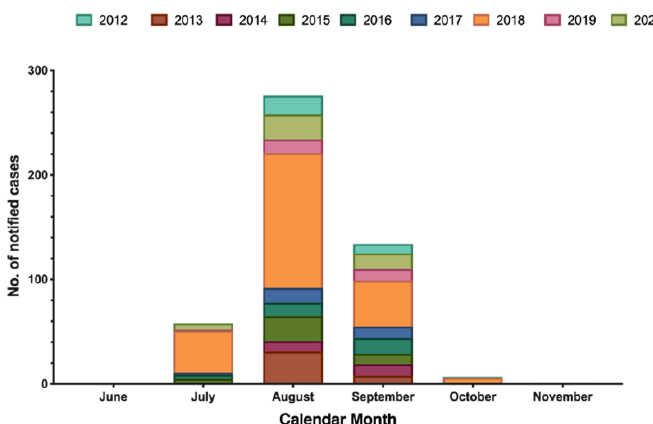
Figure 2. Number of laboratory diagnosed West Nile neuro-invasive disease (WNND) cases by month of symptom onset, Italy (2012 – 2020; no. = 487).